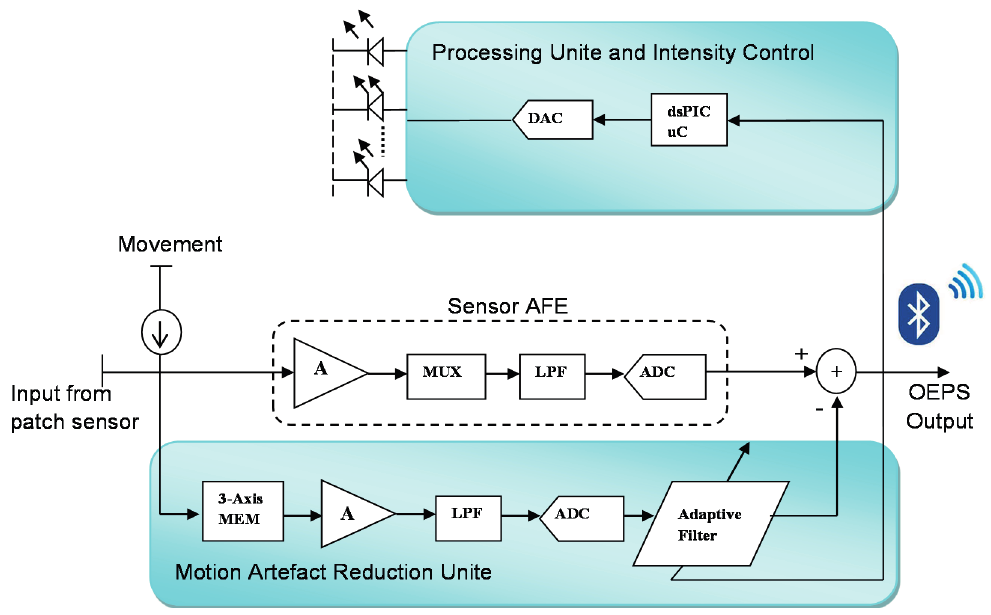
Figure 3. Electronic system structure of OEPS for continuous physiological monitoring.